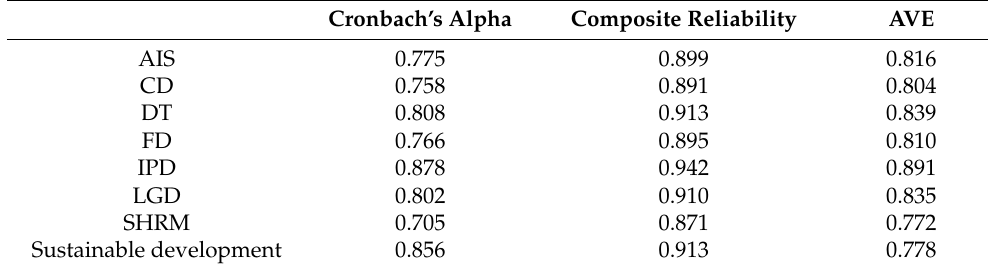
Table 3. Validity and reliability.